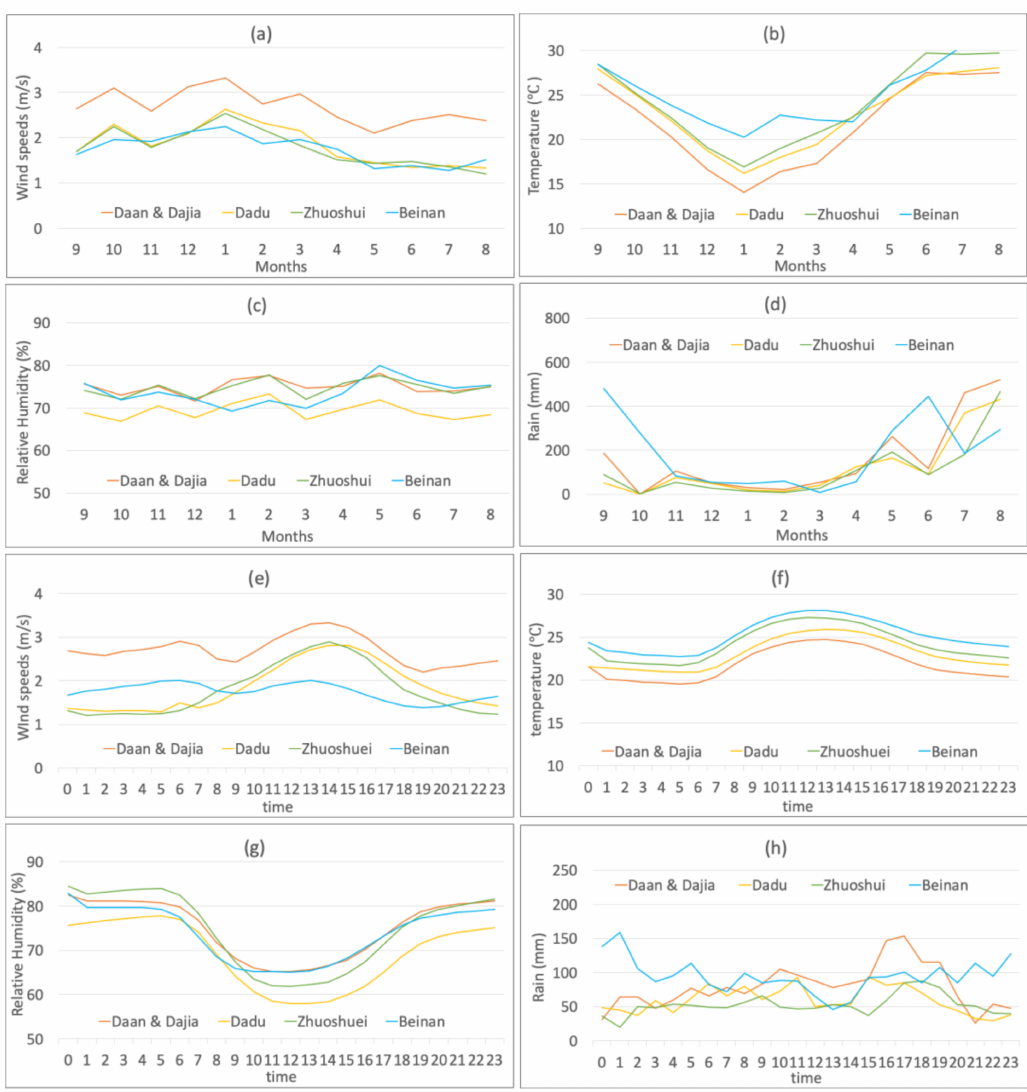
Figure 7. Monthly and hourly mean ( a , e ) wind speeds, ( b , f ) temperatures, and ( c , g ) relative humidity obtained from riverbed monitoring stations, and ( d , h ) rainfall amounts obtained from the closest EPA monitoring stations adjacent to each of the riverbed